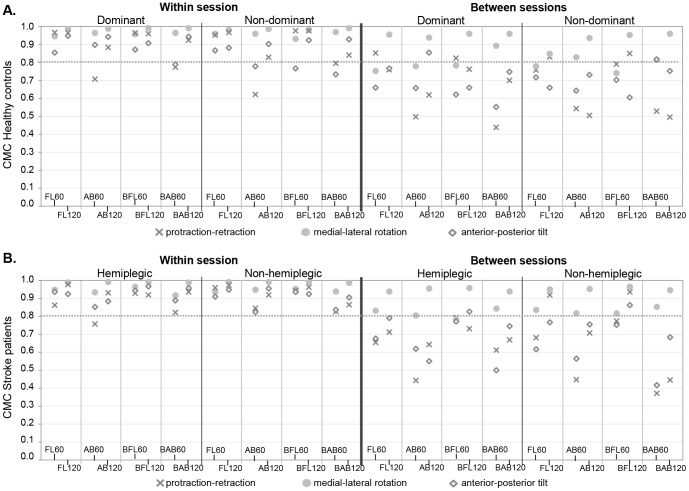
Within and between session reliability of angular waveforms.CMCs in healthy controls (A) and CMCs in stroke patients (B); FL: anteflexion; AB: abduction; BFL: bilateral anteflexion; BAB: bilateral abduction; No symbol is shown in case of calculation errors.